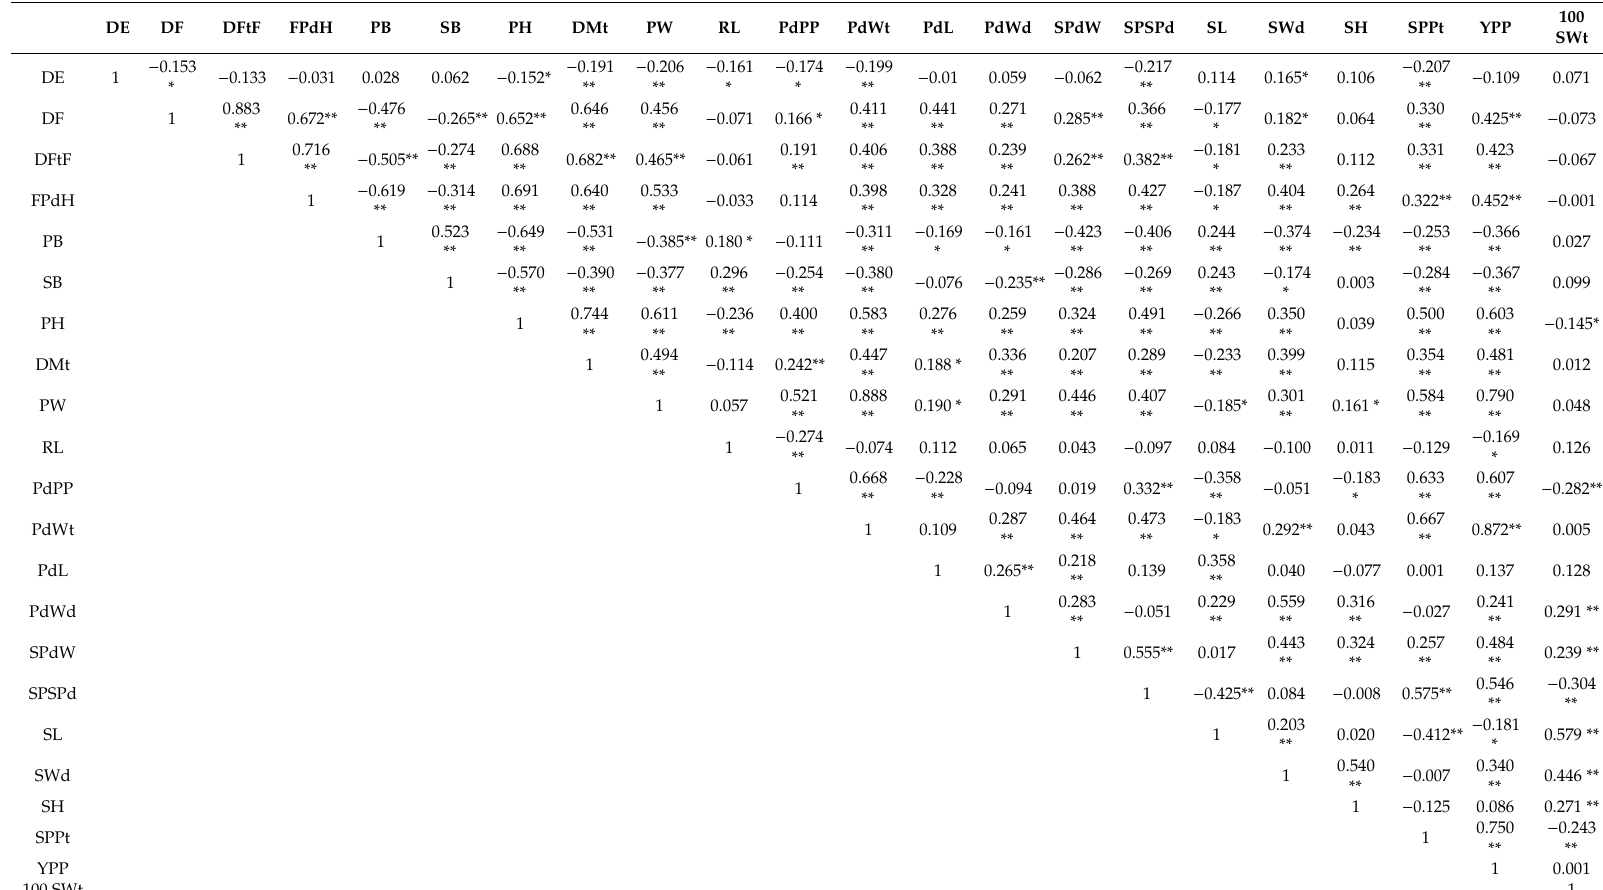
Table 5. Correlation coe ffi cients among 22 agro-morphological traits of Turkish common bean